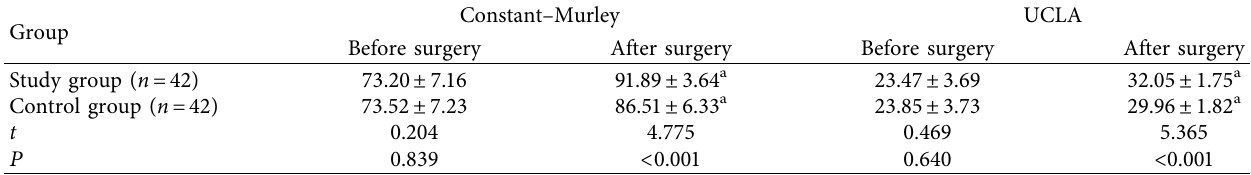
Table 2: Comparison of Constant–Murley and UCLA scores before and after surgery in two groups ( x ± S , score). Group